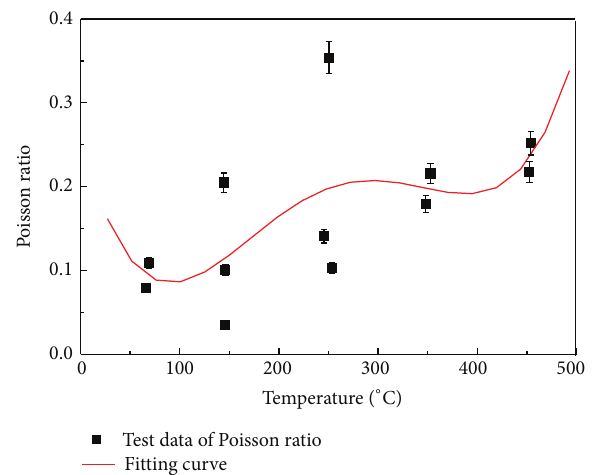
Figure 7: Poisson ratio curve under different temperatures in